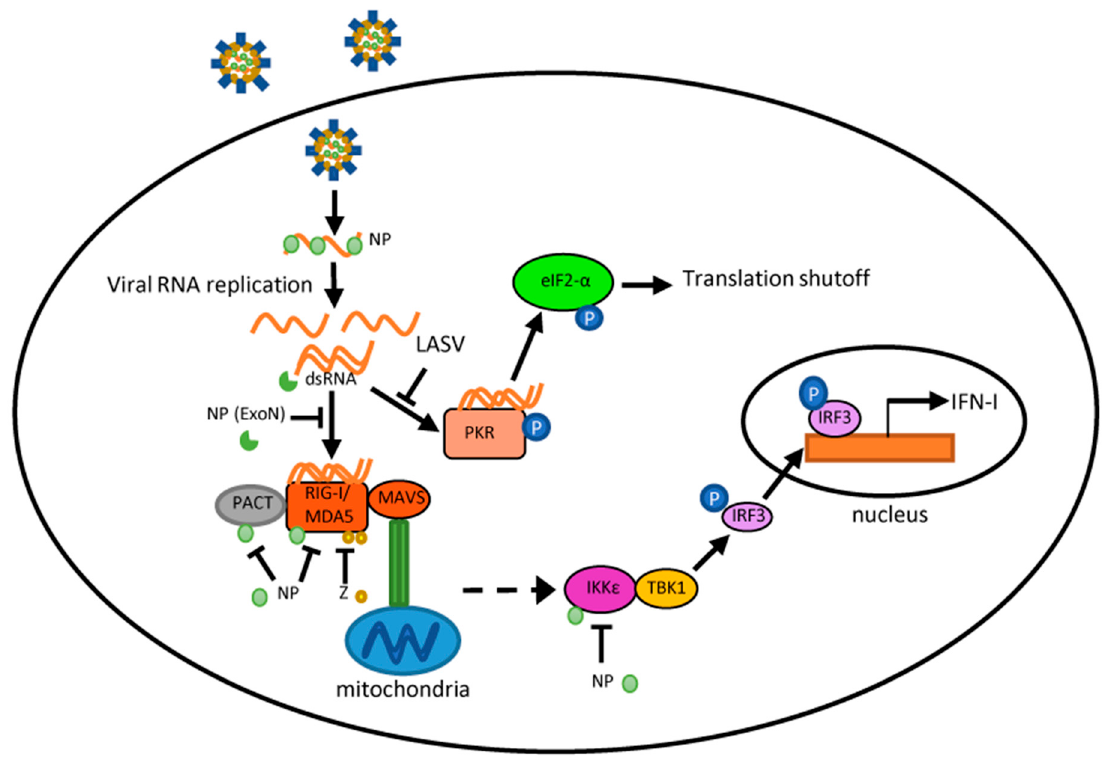
Figure 2. Schematic diagram of interactions between arenavirus proteins and host innate immune machinery. During arenavirus infection, viral-derived double-stranded RNA (dsRNA) molecules may be produced during viral RNA synthesis and recognized by host dsRNA sensor RIG-I-like receptors (RLRs) and protein kinase R (PKR). This may trigger a signaling cascade that leads to a Type I interferon (IFN-I) response and PKR response, respectively. The nucleoprotein (NP) exonuclease (ExoN) efficaciously degrades dsRNA in biochemistry assays. Plasmid-expressed NP and the Z of pathogenic arenaviruses also block the IFN pathway at several different points. During infection, the interaction of highly pathogenic arenaviruses with the RLR and PKR pathways differs remarkably, which is discussed in the text.